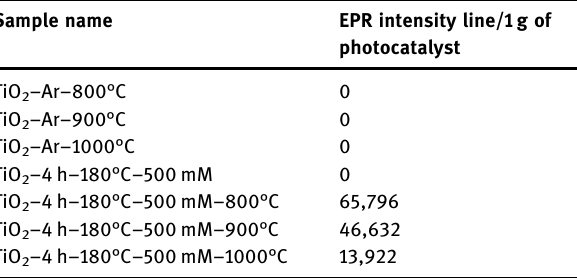
Table 3: Summary of the EPR signal intensity in studied samples